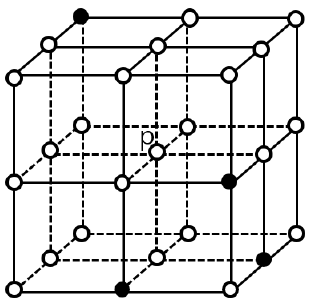
Figure 9. Another example of disconnection.